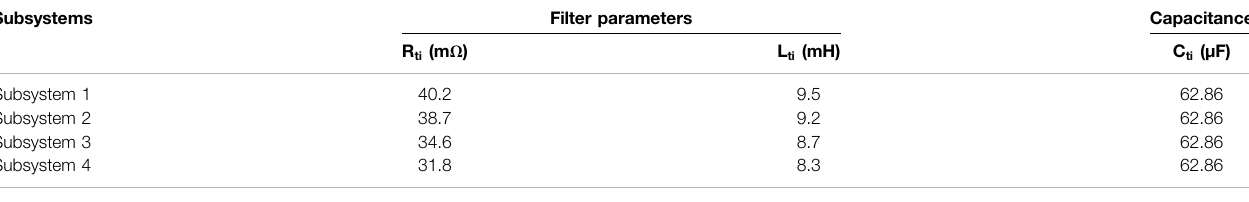
TABLE 1 | Electrical parameters of the microgrid.